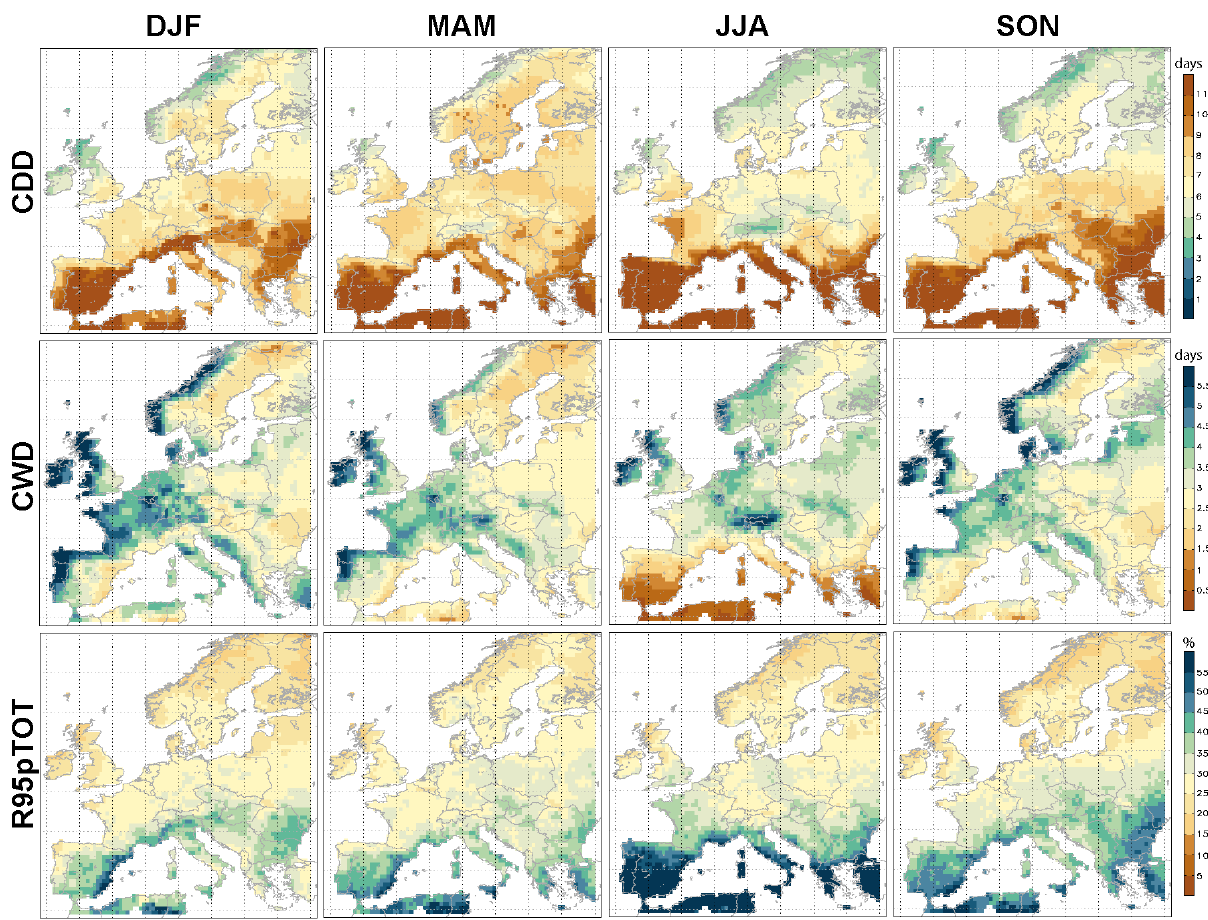
Fig. 1. Seasonal mean distribution of CDD (days), CWD (days) and R95pTOT (%) for the different seasons